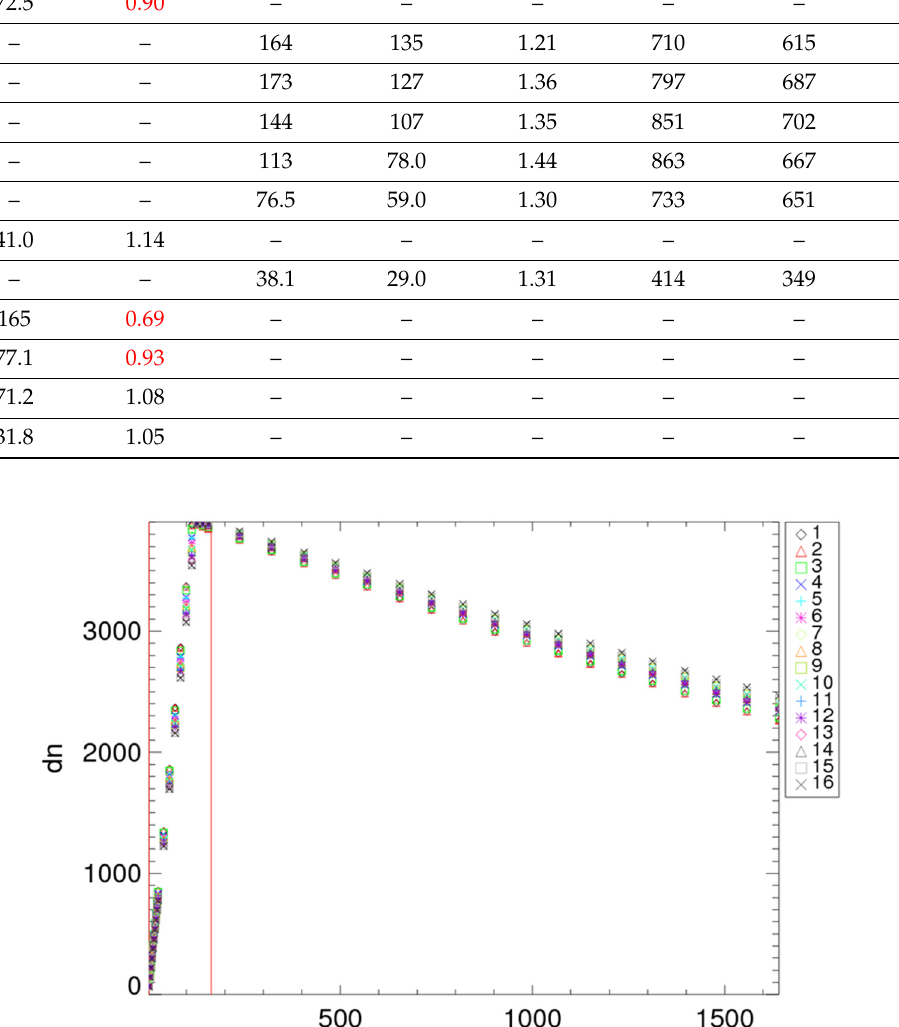
Figure 7. Band M8 dynamic range measurements for all detectors, legend in the upper right, for HAM side A. The y -axis is offset subtracted VIIRS response, and the x -axis is the SIS100 radiance during the measurement. The vertical red line corresponds to Lmax, and the saturation occurs before the line. The rollover in the response is due to saturation of the focal plane electronics. This causes two unique radiance levels to produce the same VIIRS digital number.